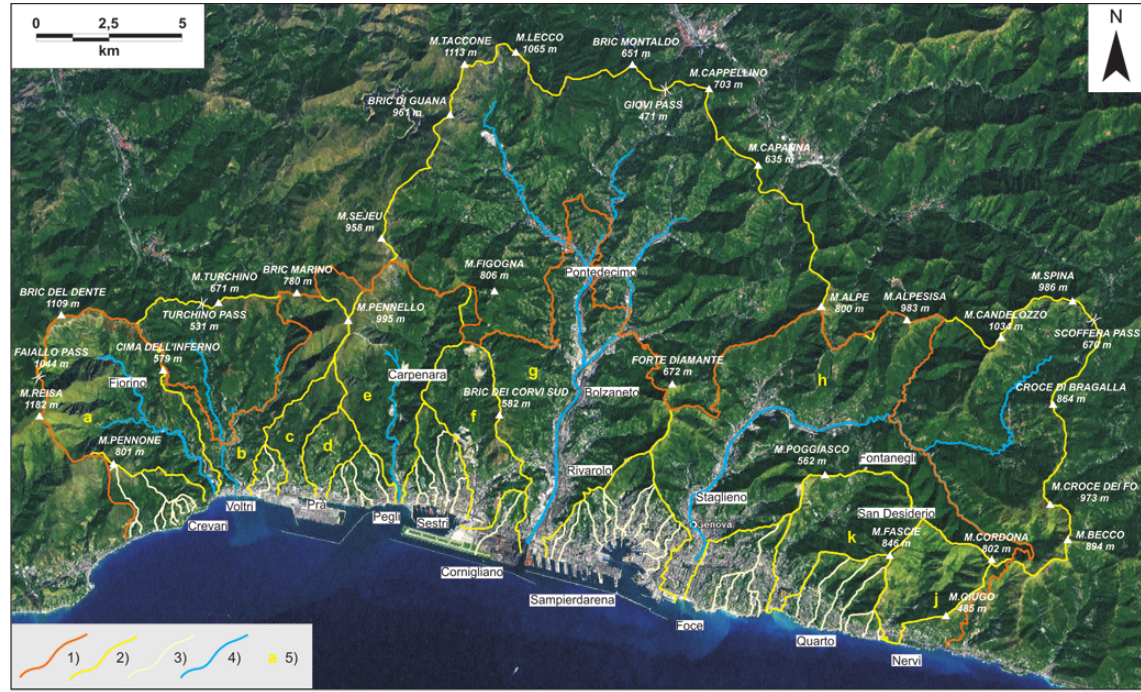
Fig. 3. Morphological map of the study area. Base image from TerraExplorer® (2011). Legend: (1) Genoa Municipality boundaries; (2) catchments boundaries; (3) sub-catchments boundaries; (4) main water courses; (5) catchments: Cerusa (a); Leiro (b); Branega (c); San Pietro (d); Varenna (e); Chiaravagna (f); Polcevera (g); Bisagno (h); Sturla (k); Nervi (j).